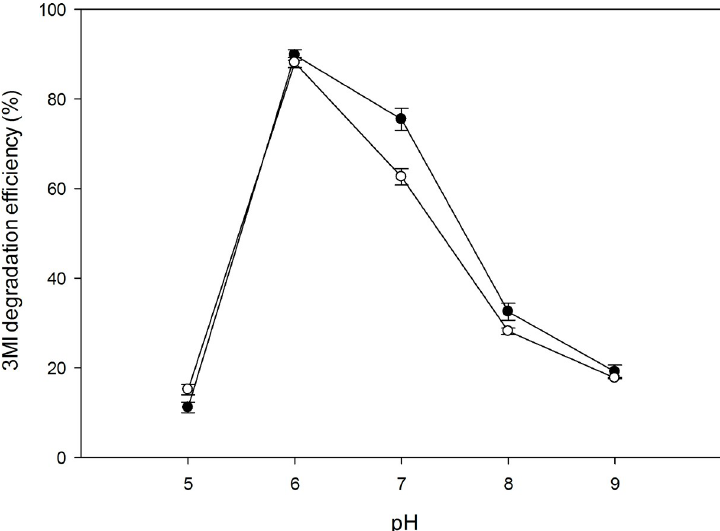
Fig 6. Effect of pH on 3MI degradation efficiency by the strains at T31, and 1 mM (131.17 mg/L) 3MI concentration. Symbols: open circle, NTA1-2A strain; solid circle, TAT1-6A strain.